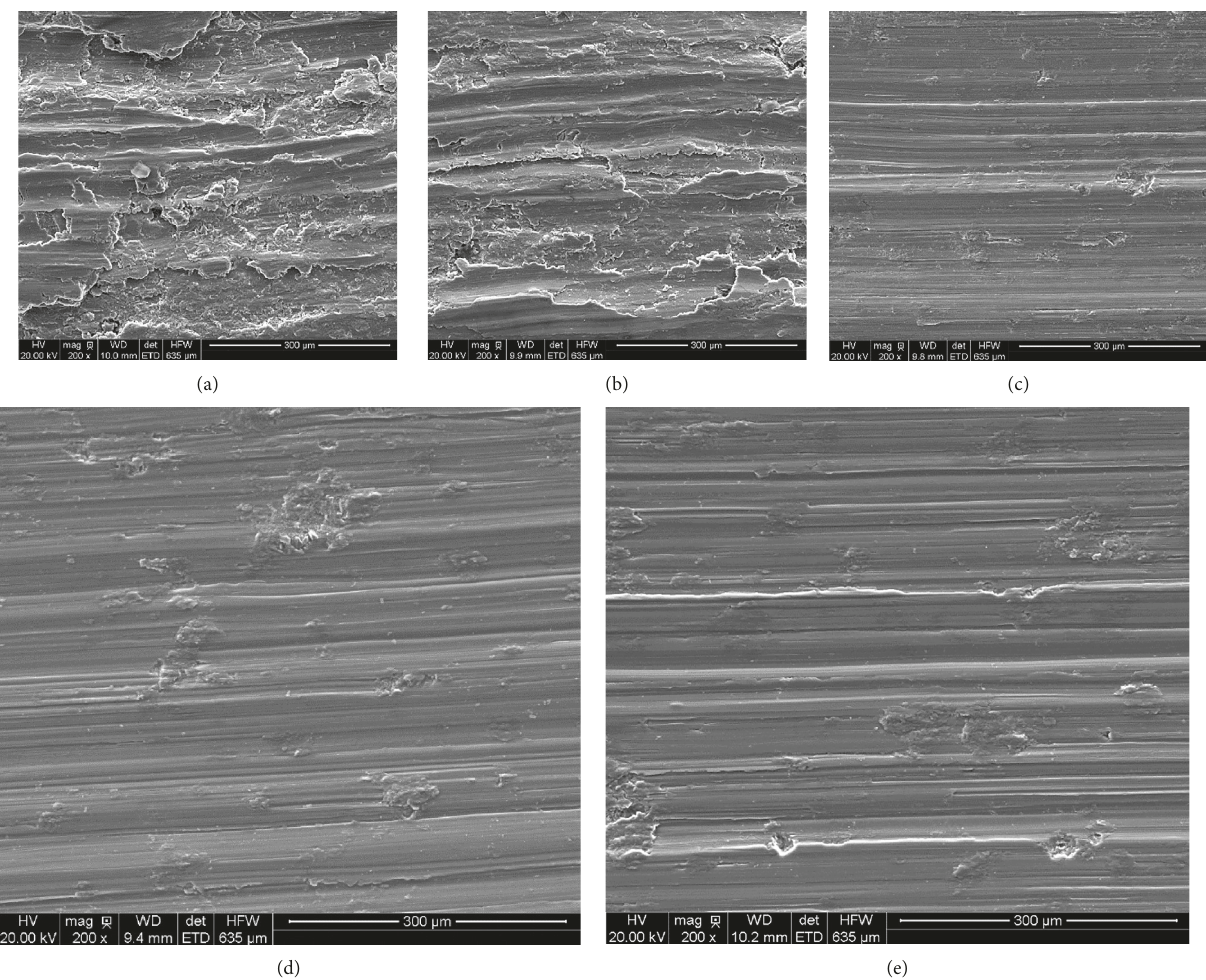
Figure 5: The typical wear track of the AZ31 magnesium alloy substrate (a), coating 0 (b), coating 10 (c), coating 20 (d), and coating 40 (e).